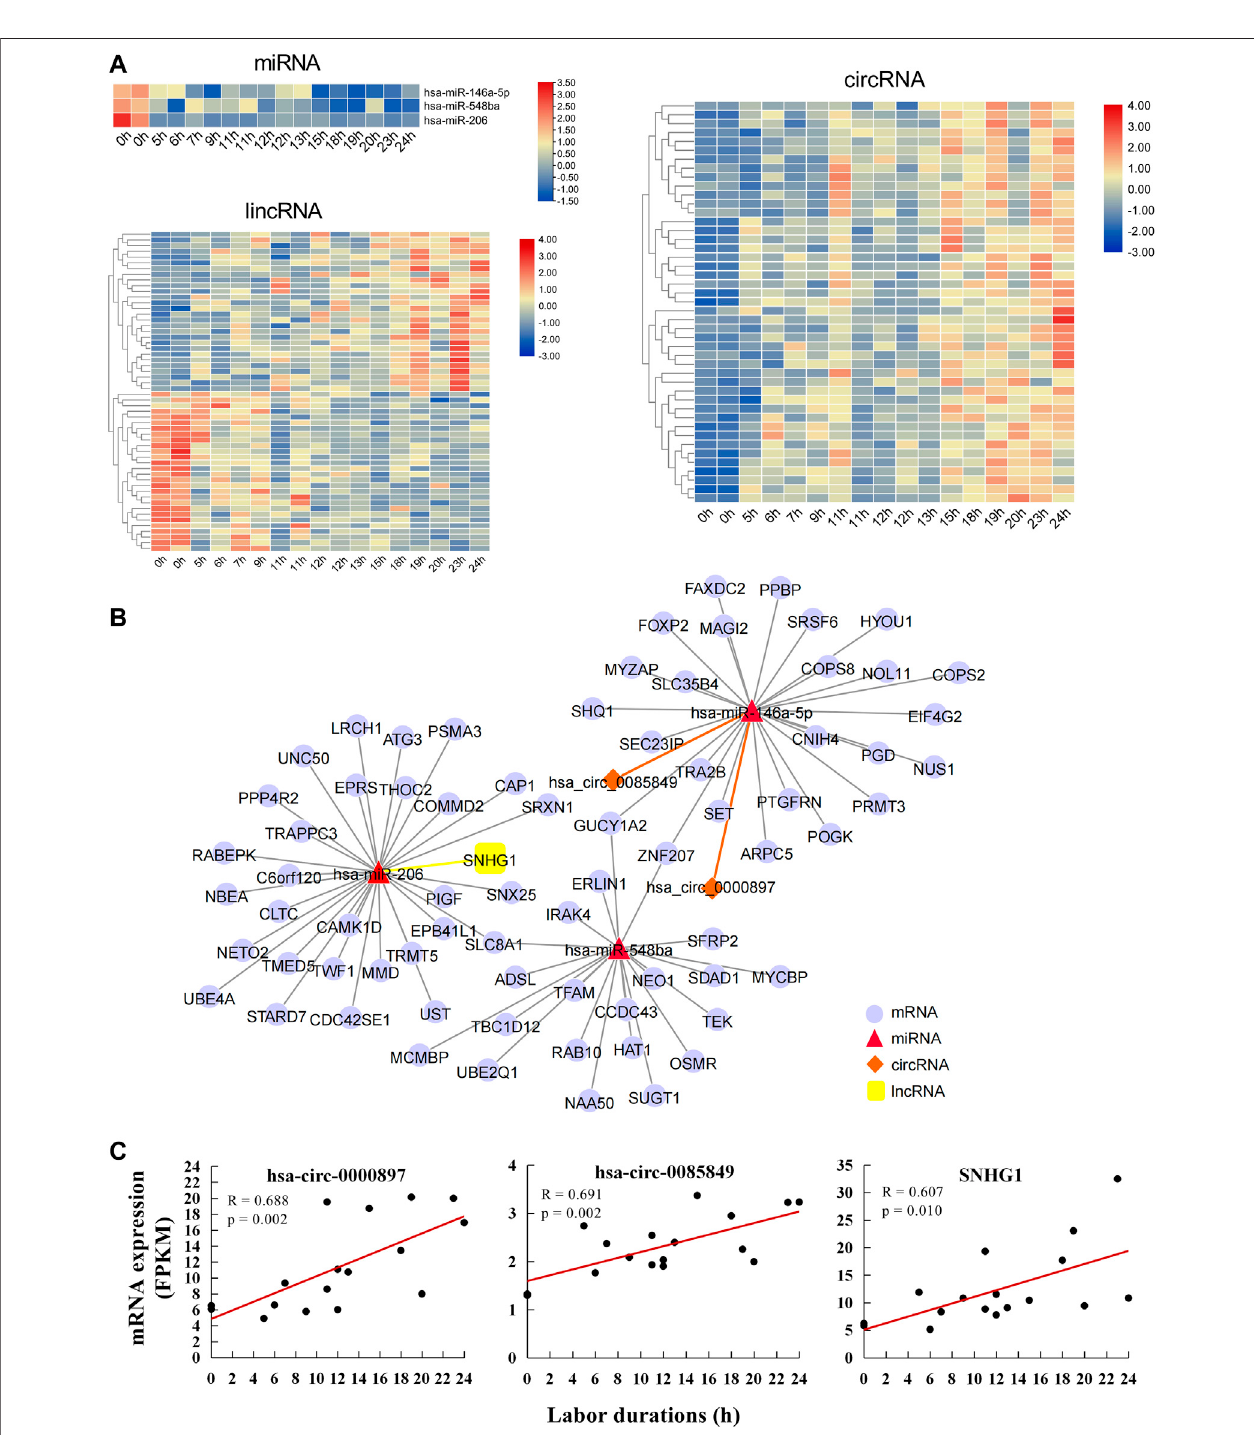
FIGURE 3 | Labor duration – correlated circRNA/lncRNA – miRNA – mRNA ceRNA network. (A) Heat map of expression of labor duration correlated miRNAs, lncRNAs, and circRNAs. Data associated with this fi gure can be found in Supplementary Table S6 . (B) Labor duration correlated ceRNA network. (C) The expression trend of ncRNAs in ceRNA network at different labor